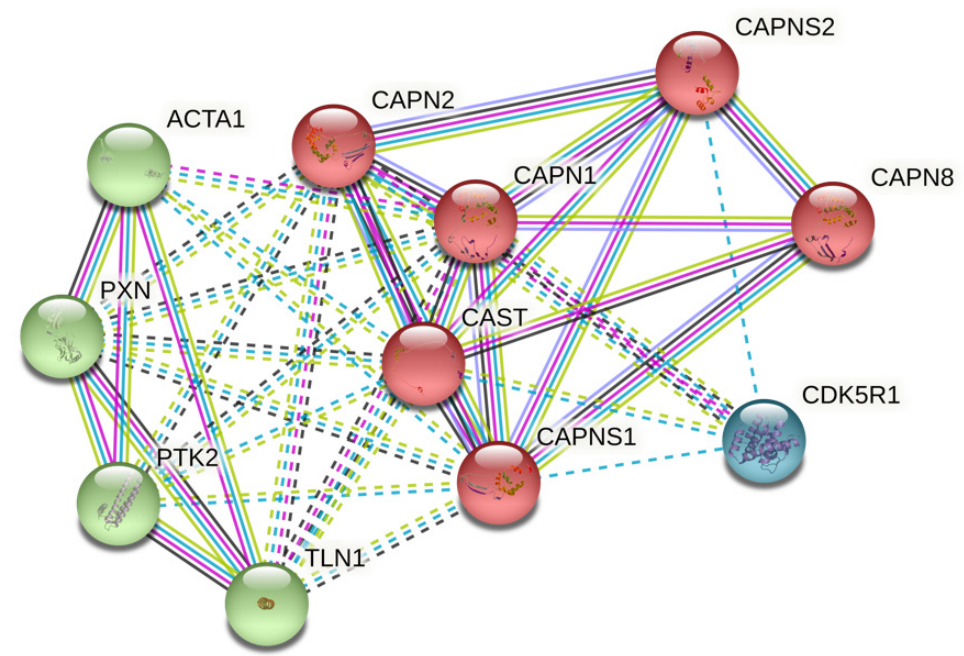
Figure 1. Important bio-targets of protein–protein interaction network in STRING clustering analysis network. Number of nodes: 11; number of edges: 40; average node degree: 7.27; average local clustering coefficient: 0.865; expected number of edges: 11; PPI enrichment p -value: 1.12 × 10 − 11 .